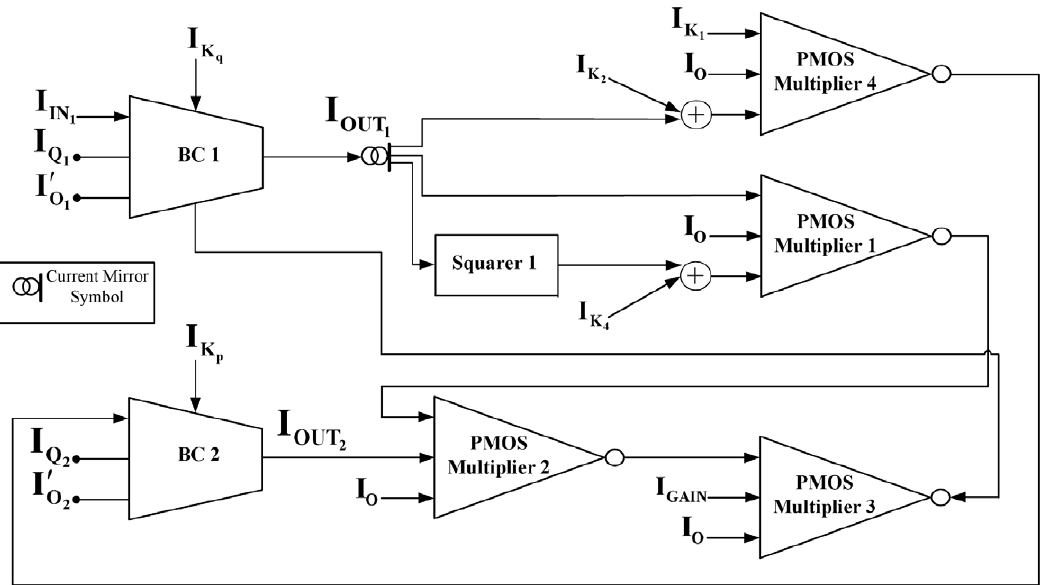
Figure 7. A block representation of the total circuit implementing the two-dimensional gene-protein regulation model as codified by (35) & (36).